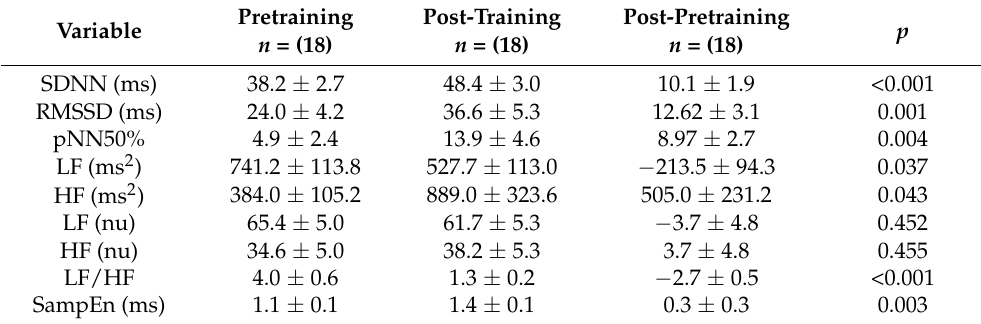
Table 3. Resting HRV before and after 12 w of exercise training ( n = 18, Mean ±